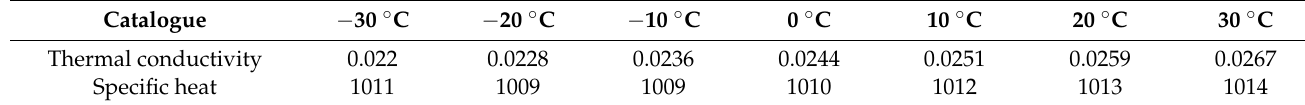
Table 6. Thermal conductivity of air (W/(m · K)).